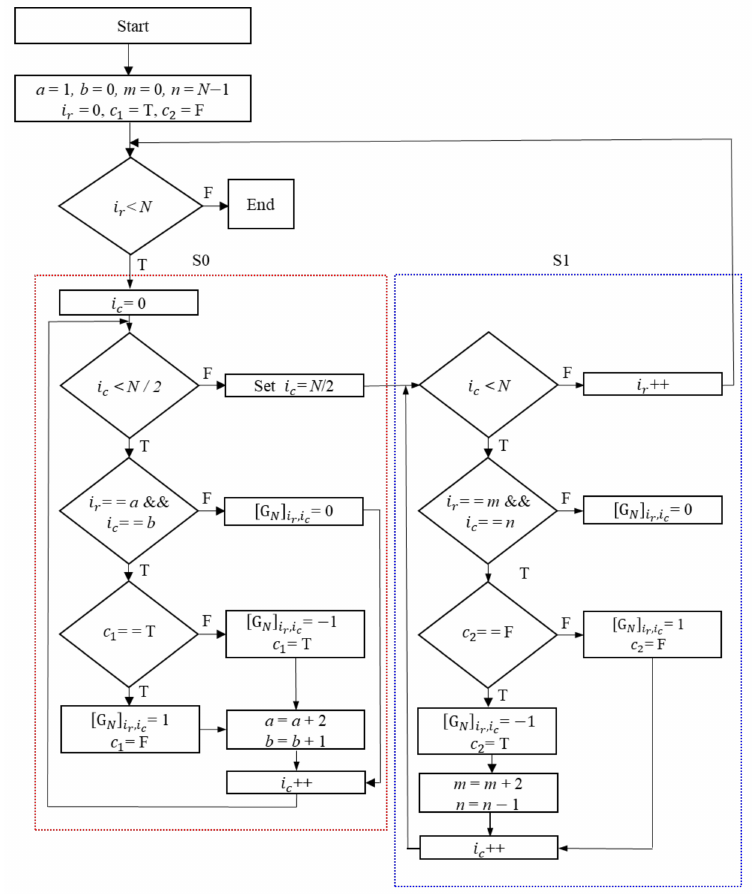
Figure 12. Algorithm for the generation of the permutation matrix G